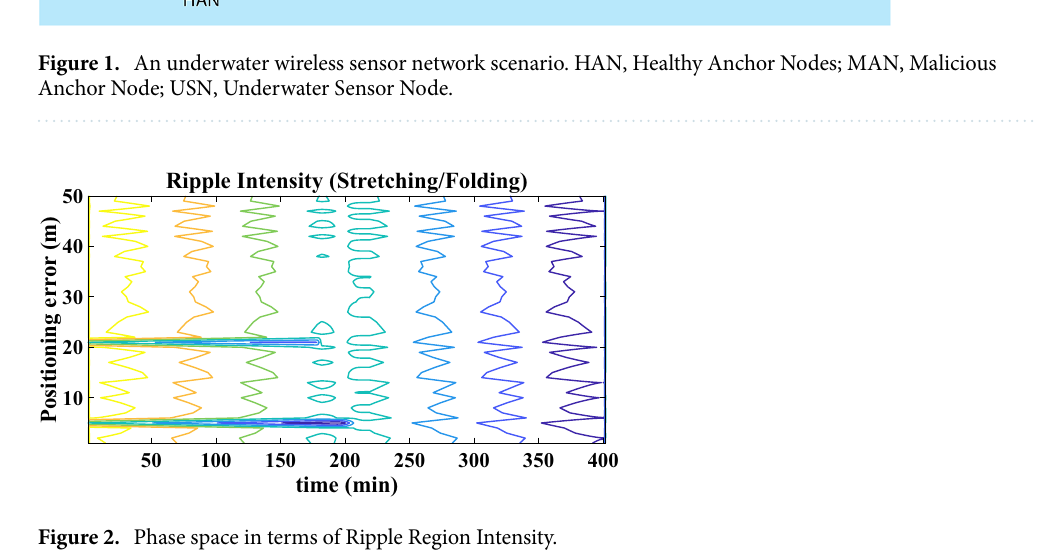
Figure 2. Phase space in terms of Ripple Region